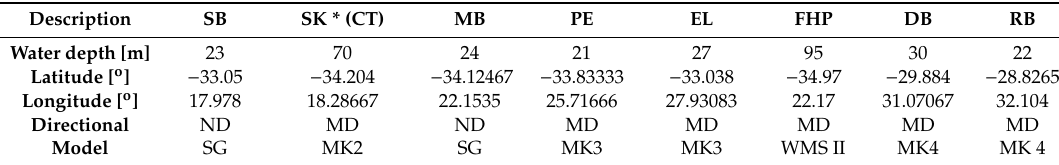
Table 1. Datawell wave rider buoy mooring depths (CD) and geographical coordinate location. Data quality control was performed at the Council for Scientific and Industrial Research (CSIR) in Stellenbosch, South Africa. The Datawell wave rider buoy used at each location is described as non-directional (ND) or multi-directional (MD), together with the model description. FHP was the only location where a WaMoS II wave radar system was used to gather